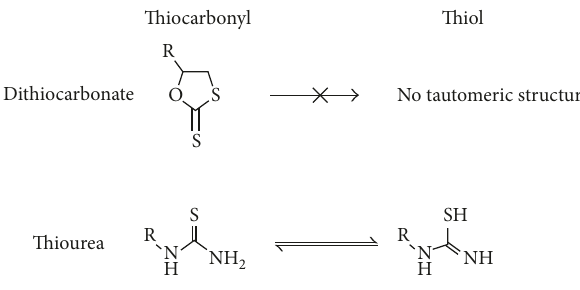
Scheme 2: Tautomeric structures of thiocarbonyl and thiol.